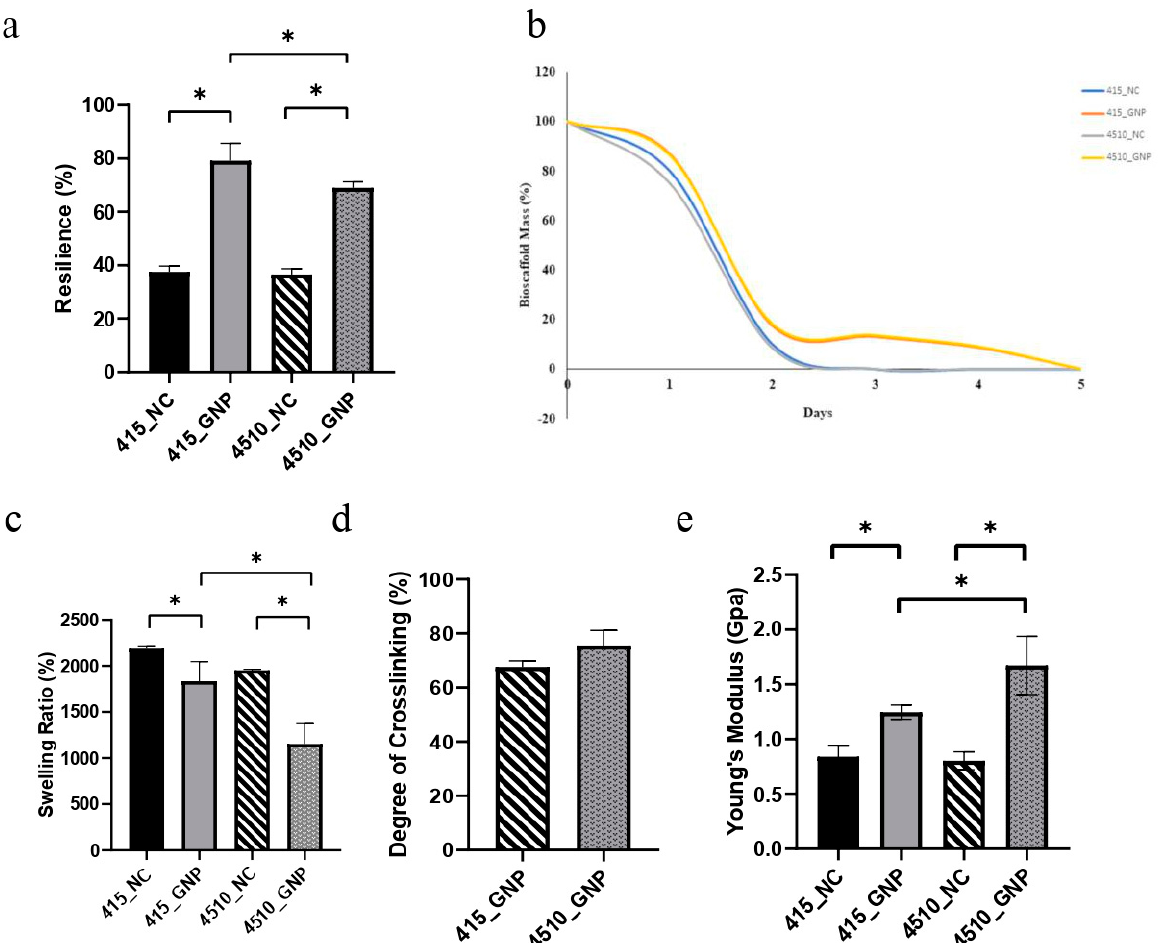
Figure 2. Effect of cross-linking on the physicochemical properties of CollaGee biomaterials. ( a ) Cross-linked groups demonstrated higher resilience than non-cross-linked groups. ( b ) Biodegradation rate showed cross-linked groups had a low biodegradation rate that was good for tissue regeneration. ( c ) Cross-linked groups had a swelling ratio of more than 1000%. ( d ) Post-cross-linking showed more than a 60% cross-linking degree. ( e ) Cross-linked groups had higher mechanical strength than non-cross-linked groups. The 4510_GNP had significantly higher mechanical strength than did 415_GNP. * p < 0.05.